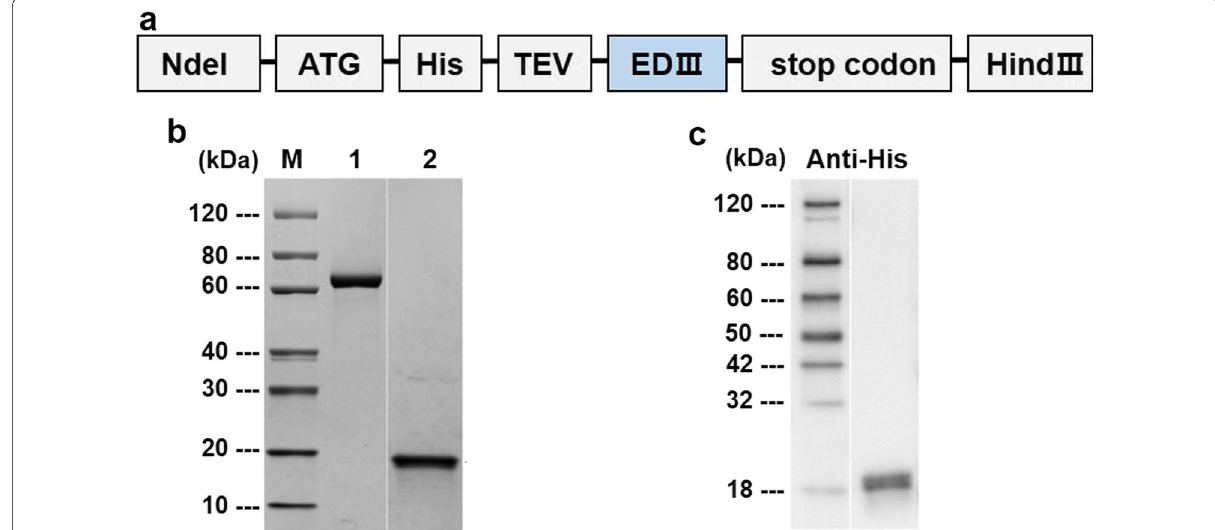
Fig. 1 Construction of Z_EDIII. a Schematic of constructs expressing Z_EDIII (TEV: TEV protease site). b , c Purified Z_EDIII proteins were confirmed by SDS‑PAGE b and Western blot c . b Lane M: Protein Marker (GenScript, Cat. No. M00516). Lane 1: BSA (2 μg). Lane 2: Target protein (Z_EDIII 2 μg). c The primary antibodies used anti‑His antibody (Mouse‑anti‑His mAb, GenScript, Cat. No.